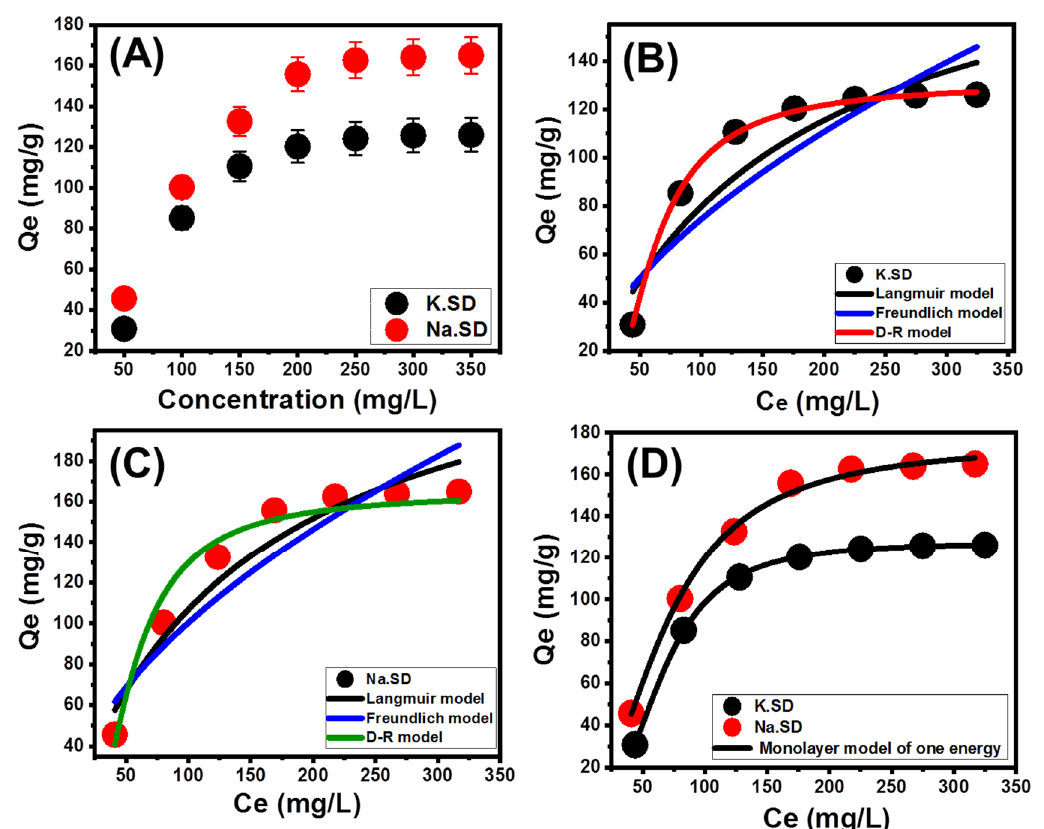
Figure 6. Effect of the PO 43 − concentrations on the sequestration capacities of Na.SD and K.SD ( A ), fitting of the PO 43 − sequestration results of K.SD with different isotherm models ( B ), fitting of the sequestration results of Na.SD with different isotherm models ( C ), and fitting of the sequestration results with the advanced monolayer model of one energy site ( D ) (pH 6, 20 °C temperature, 0.1 g L − 1 dosage, and 960 min adsorption duration).